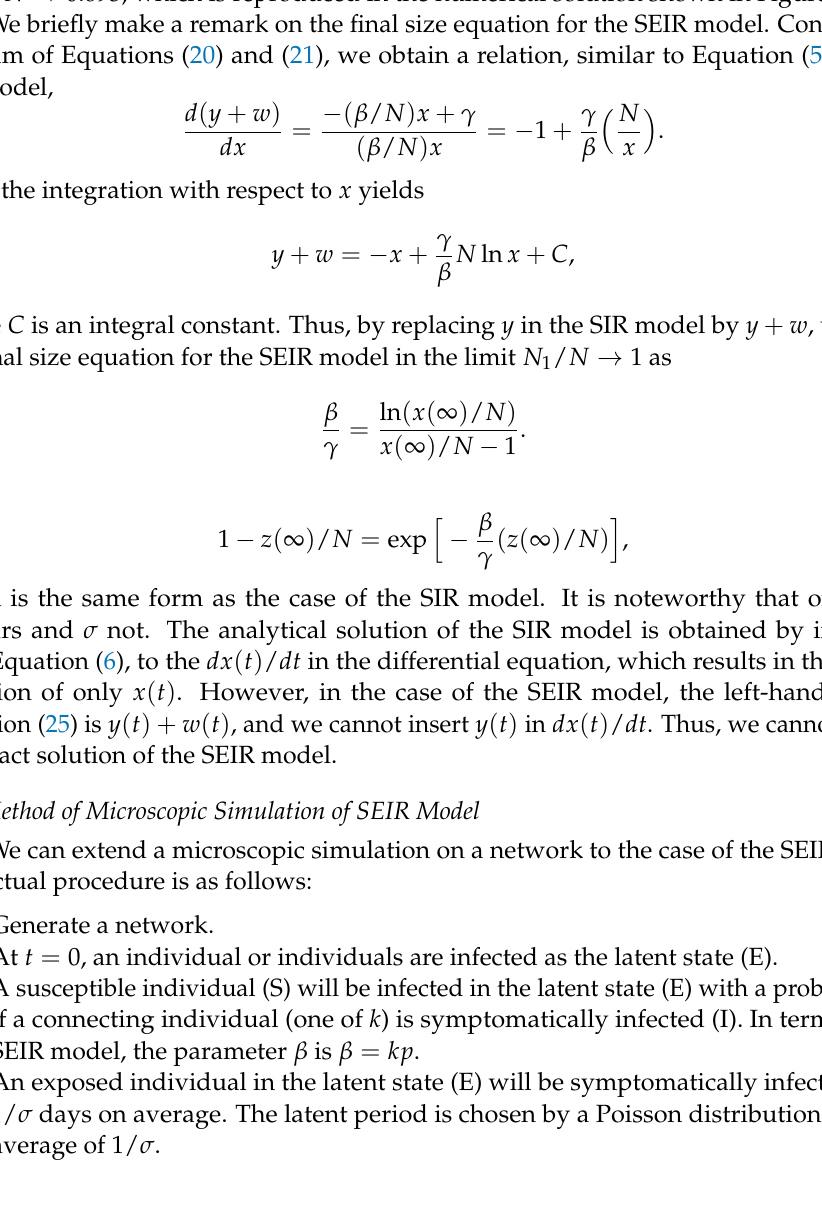
Figure 14. The numerical solution of the SEIR model using the second-order Runge–Kutta method. The ratio of the final infected individuals, ζ = z ( ∞ ) / N , is obtained as the final size equation. In the limit of N 1 / N → 1, the final size equation becomes R 0 = − ( ln ( 1 − ζ )) / ζ , which is the same form as the SIR model. For R 0 = β / γ = 2.5, it can be shown that z ( ∞ ) / N → 0.893, which is reproduced in the numerical solution shown in Figure